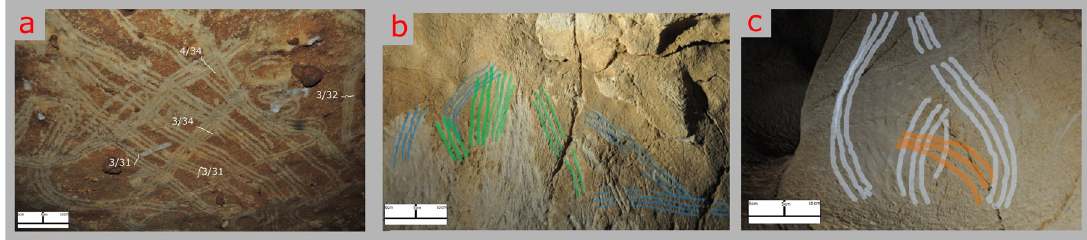
Figure 8. Flutings by (a) two children under the age of seven (31mm and 34mm) in Rouffignac, (b) two children in Chimeneas, and (c) two adults in Las Chimeneas, demonstrating the contemporaneous nature of the